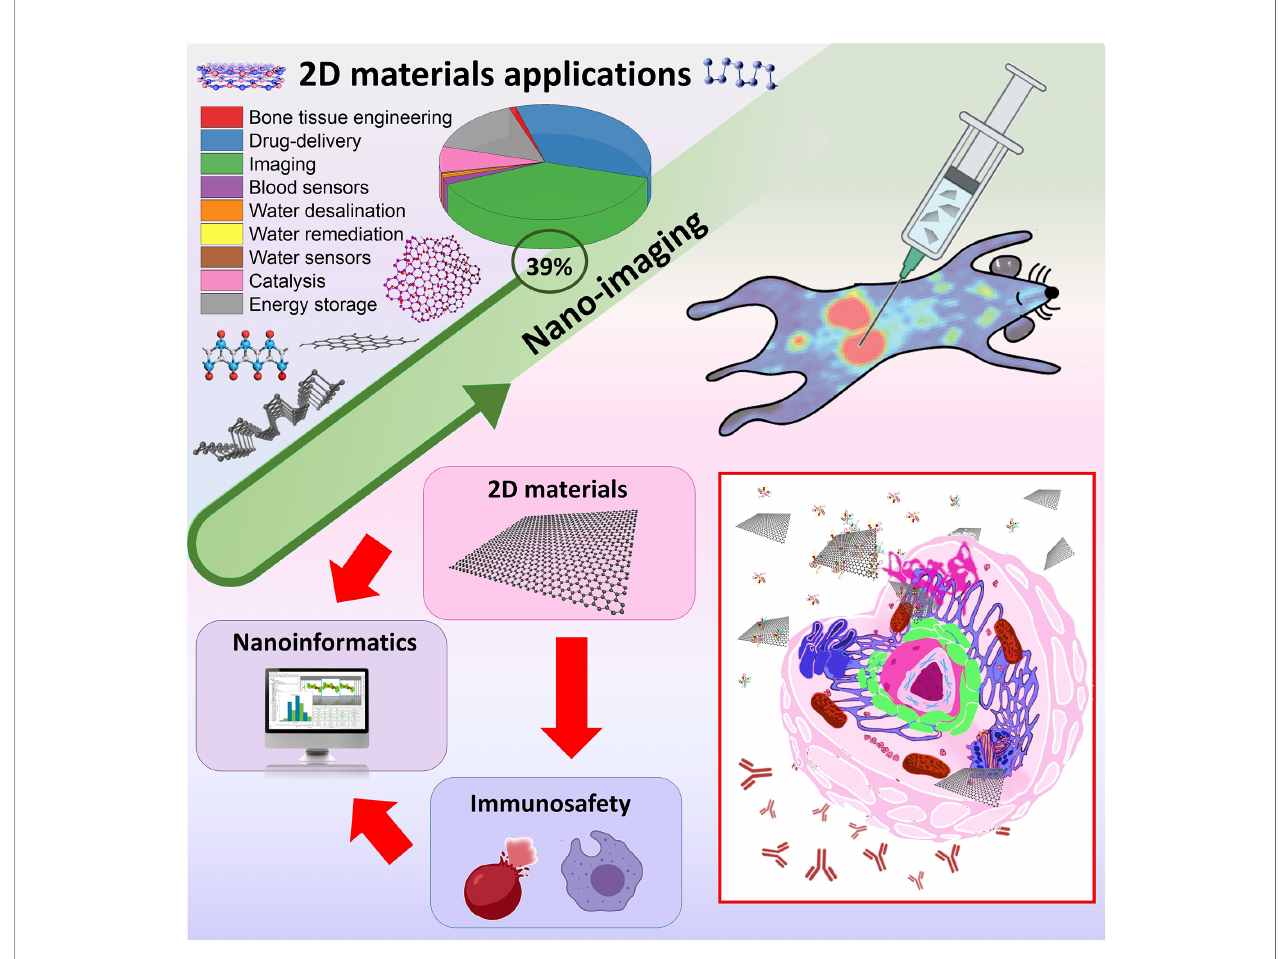
FIGURE 1 | Two-dimensional materials applications, nano-imaging and their links with immunosafety and nanoinformatics